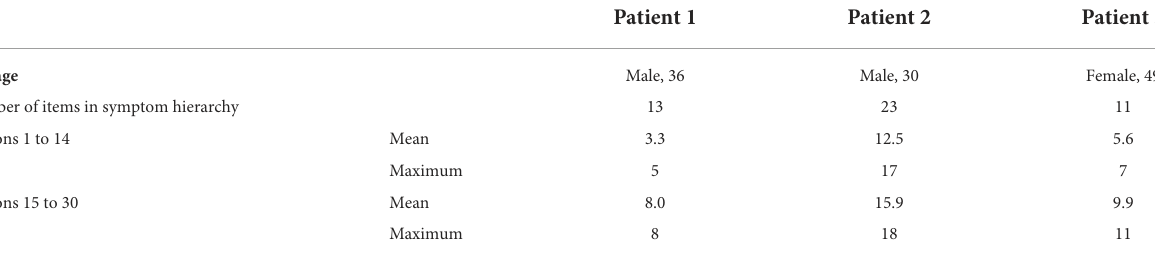
TABLE 3 Progression in symptom provocation hierarchy across session of three patients with OCD treated with TMS in our clinical